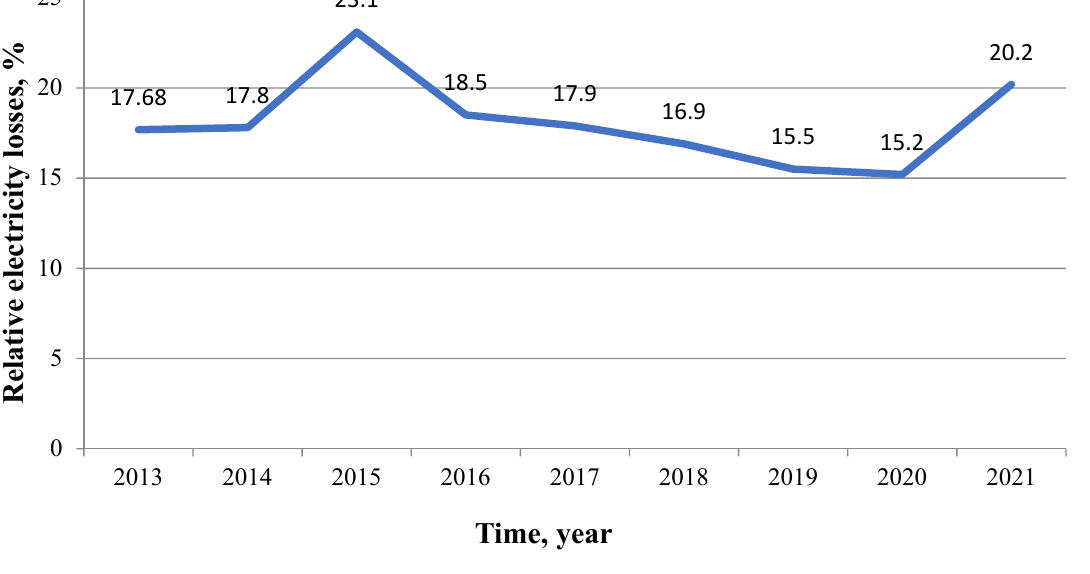
Figure 2. Dynamics of the relative electricity losses for the period of 2013–2021.